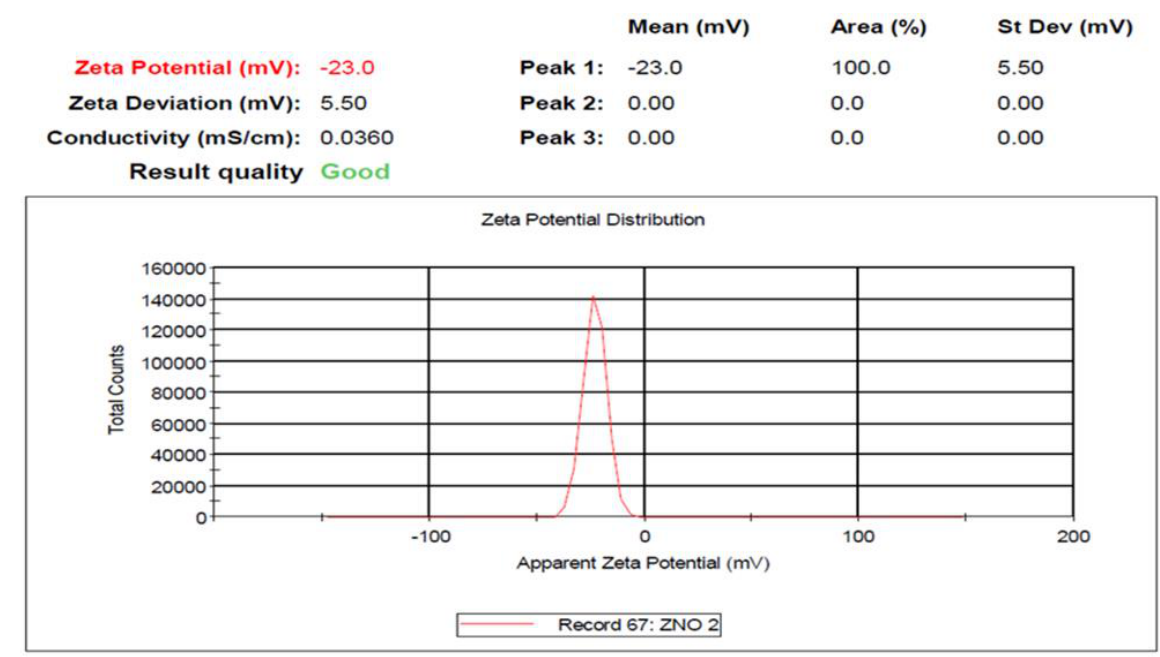
Figure 3. Zeta potential analysis of the biosynthesized ZnO NPs.